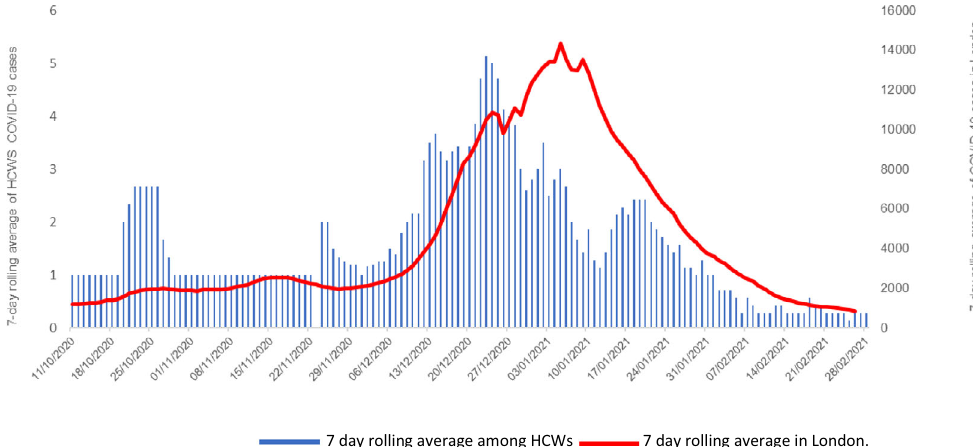
Fig. 1 The 7-day rolling average of COVID-19 cases for the study hospital compared with the London regional average. London date includes individuals with a least one positive COVID-19 test results (either laboratory reported or lateral fl ow device). The date of a new case de fi ned by the specimen date. HCW cohort included cases with a positive laboratory COVID-19 test. HCWs with HCWs with a previous positive within 90 days were excluded. The date of a new case de fi ned as date of symptom onset or specimen date if asymptomatic. The rolling 7-day average of con fi rmed cases in the London Region (red) was 14,326.6 on 5 January, decreasing to 843.4 on 26 February 2021. The rolling 7-day average of new cases in HCWs at the study hospital (blue) was 3.0 on 5 January, decreasing to 0.3 on 26 February